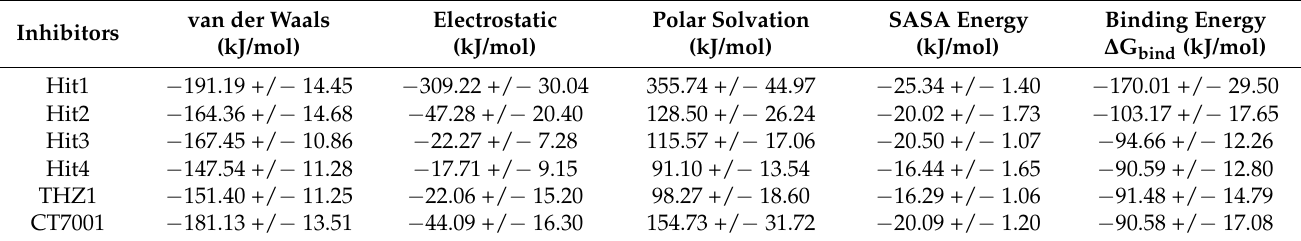
Table 4. The distribution of the total binding free energy scores for reference inhibitors and identified hits with CDK7 calculated through MM-PBSA methodology.